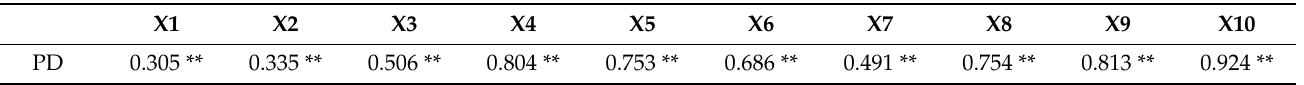
Table 1. PD values of various meteorological factors (X1–X8 represent atmospheric pressure, sun- shine, relative humidity, water vapor pressure, temperature, precipitation, wind velocity, and mean maximum temperature, respectively), winter wheat growth stage (X9), and winter wheat cultivation method (X10).